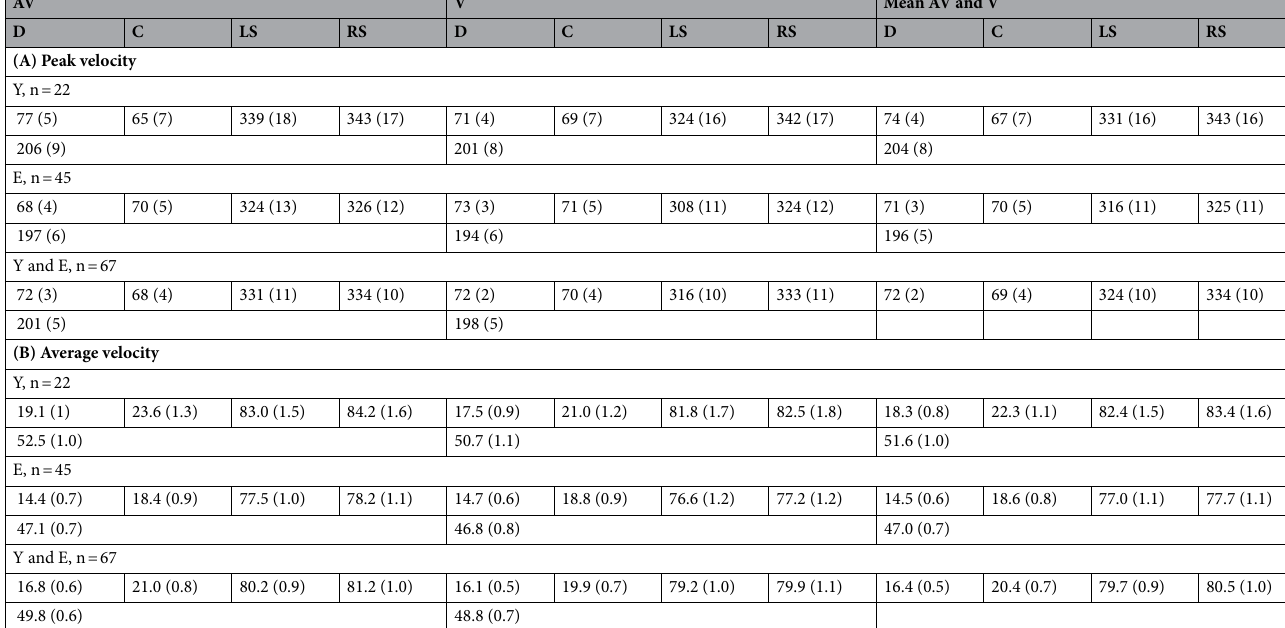
Table 2. Velocity means and standard errors. Means and sd in °/s of the peak velocity (A) and average velocity (B), by group age, movements and targets modalities. Y for the young group. E for the elderly group. A for auditory targets, AV for audiovisual targets. D for divergence, C for convergence, LS for left saccades and RS for right